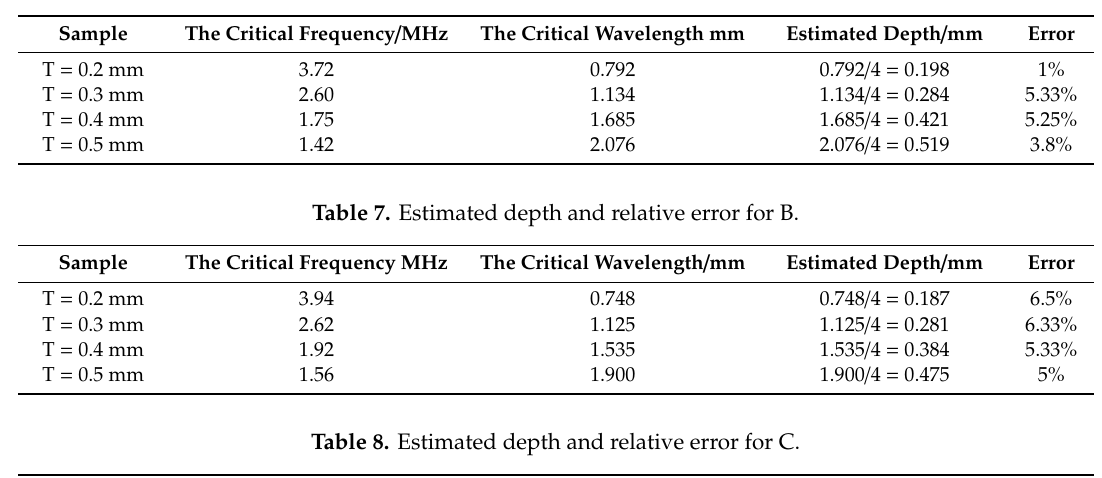
Table 6. Estimated depth and relative error for A.